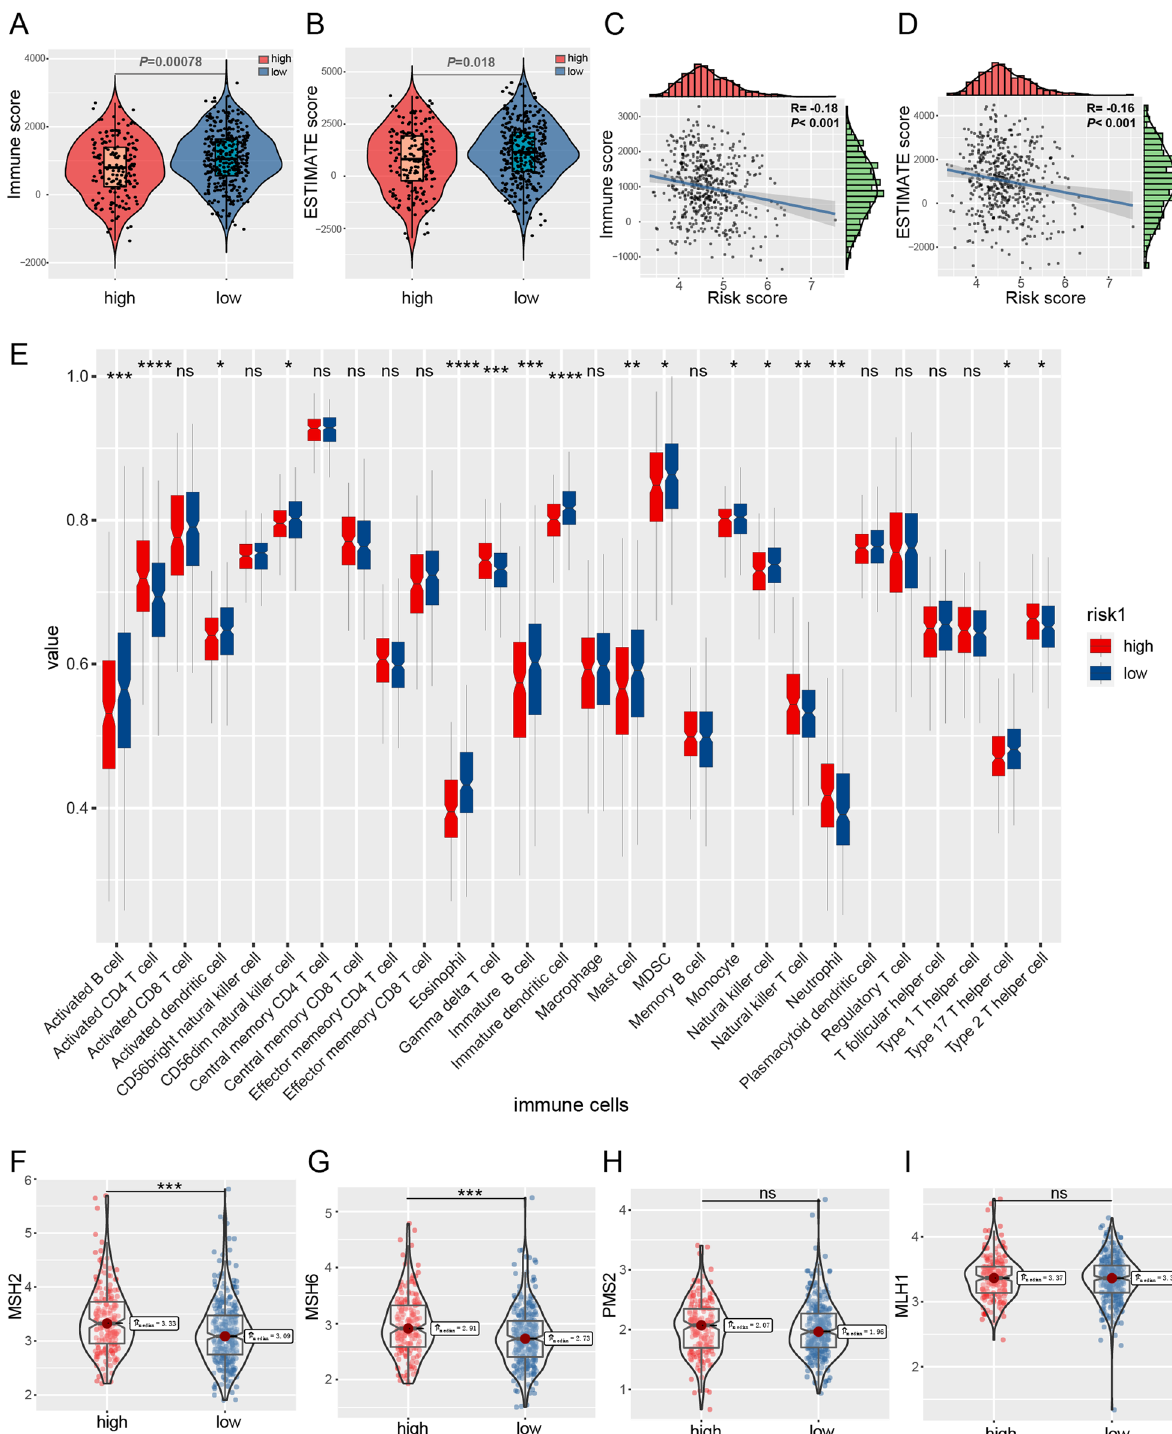
Fig. 3 Correlation between risk score and tumor immunogenicity in the TCGA-LUAD cohort. ESTIMATE algorithm indicates that immune ( A ) and ESTIMATE ( B ) scores in the high-risk group are significantly lower than those in the low-risk group. Immune ( C ) and ESTIMATE ( D ) scores are negatively associated with the risk score. E Comparison of the composition of 28 immune cell subsets in LUAD between the high- and low-risk groups. F – I In the low-risk group, there were decreased expression levels of mismatch repair genes, MSH2 and